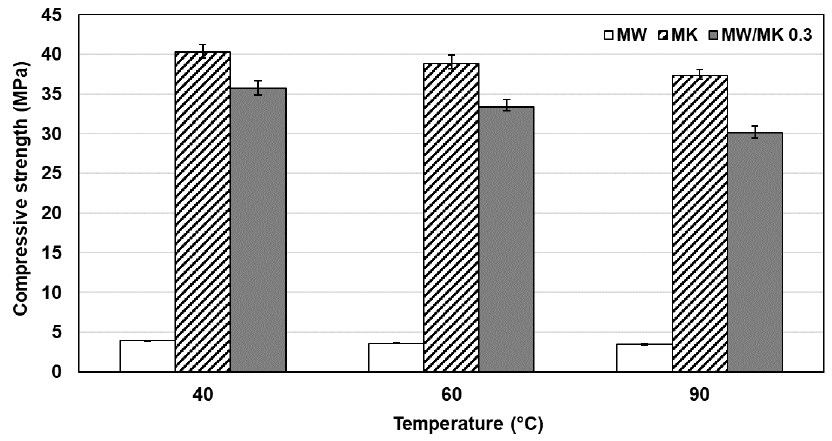
Figure 2. Effect of curing temperature on the 7-day compressive strength of alkali-activated materials (AAMs) produced with the use of marble waste to metakaolin mass ratio 0.3 and H 2 O/Na 2 O molar ratio in the activating solution 16 (median MW particle size 17.9 μm).